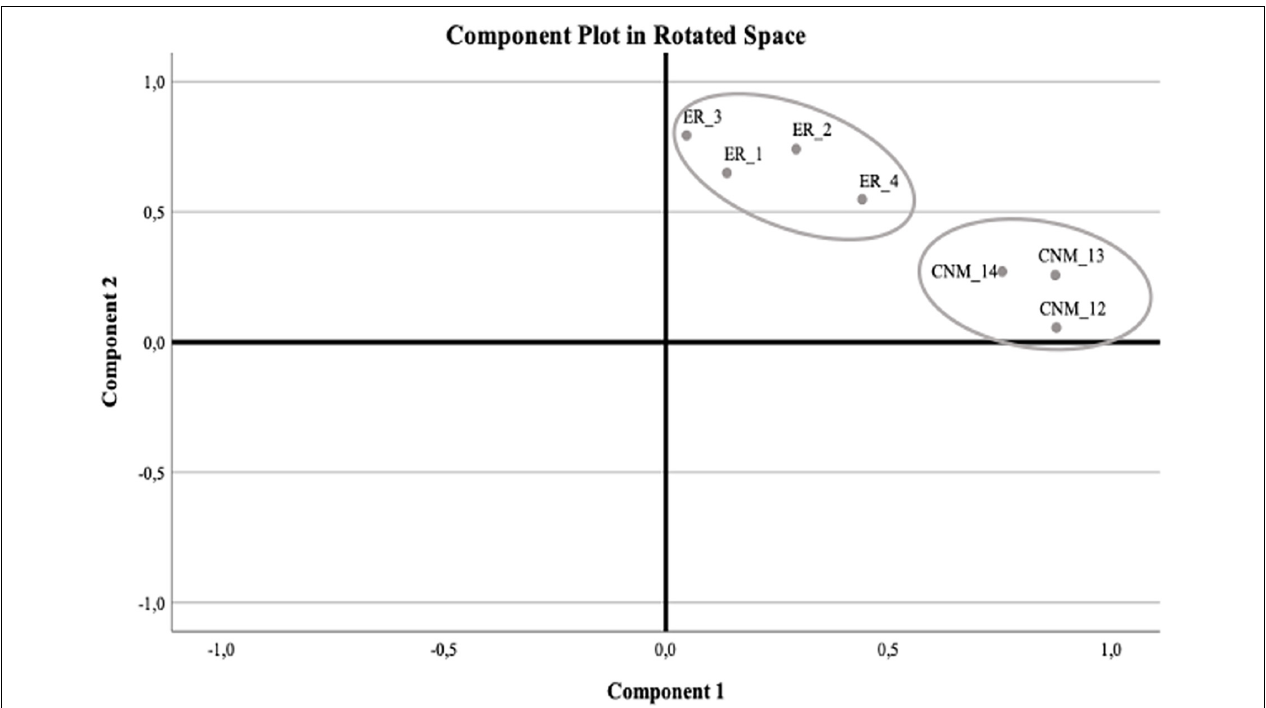
FIGURE 1 | Component plot in rotated space after principal component analysis with clearly distinct subscales “ models as exact replicas ” (ER) and “ changing nature of models ”